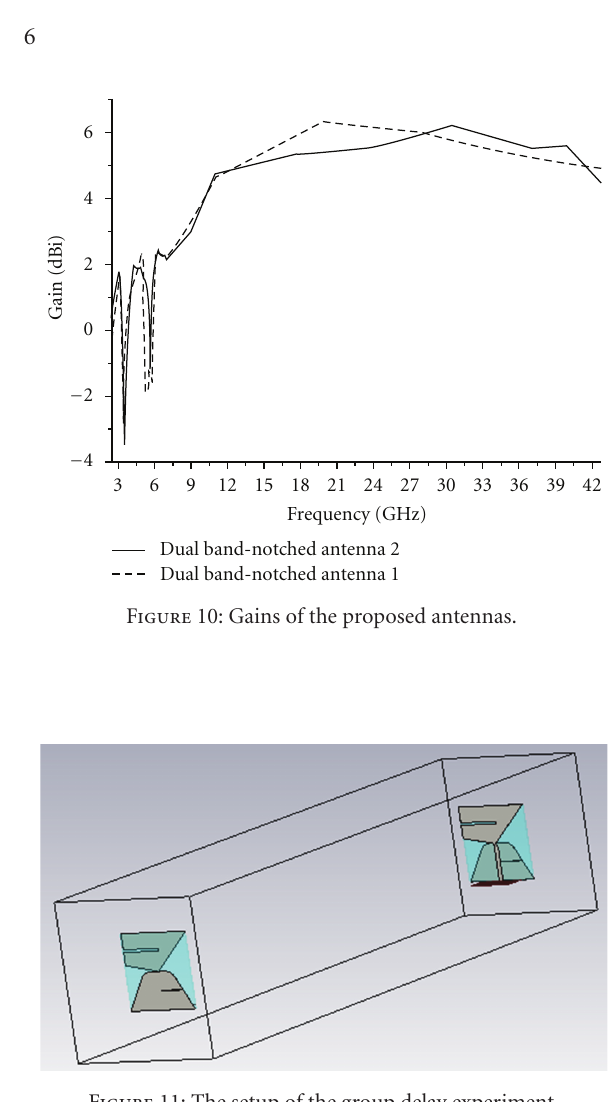
Figure 11: The setup of the group delay experiment.